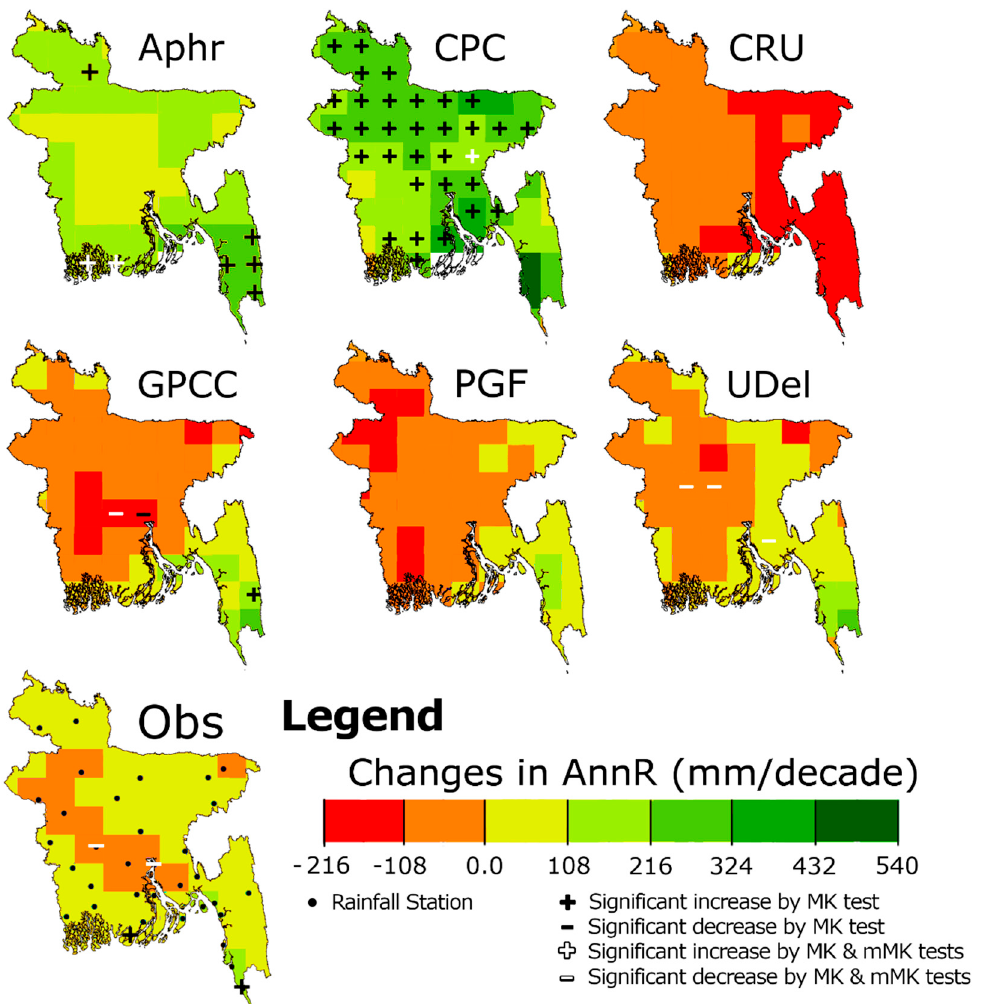
Figure 8. Trends in annual rainfall (AnnR) in Bangladesh during 1979–2010.